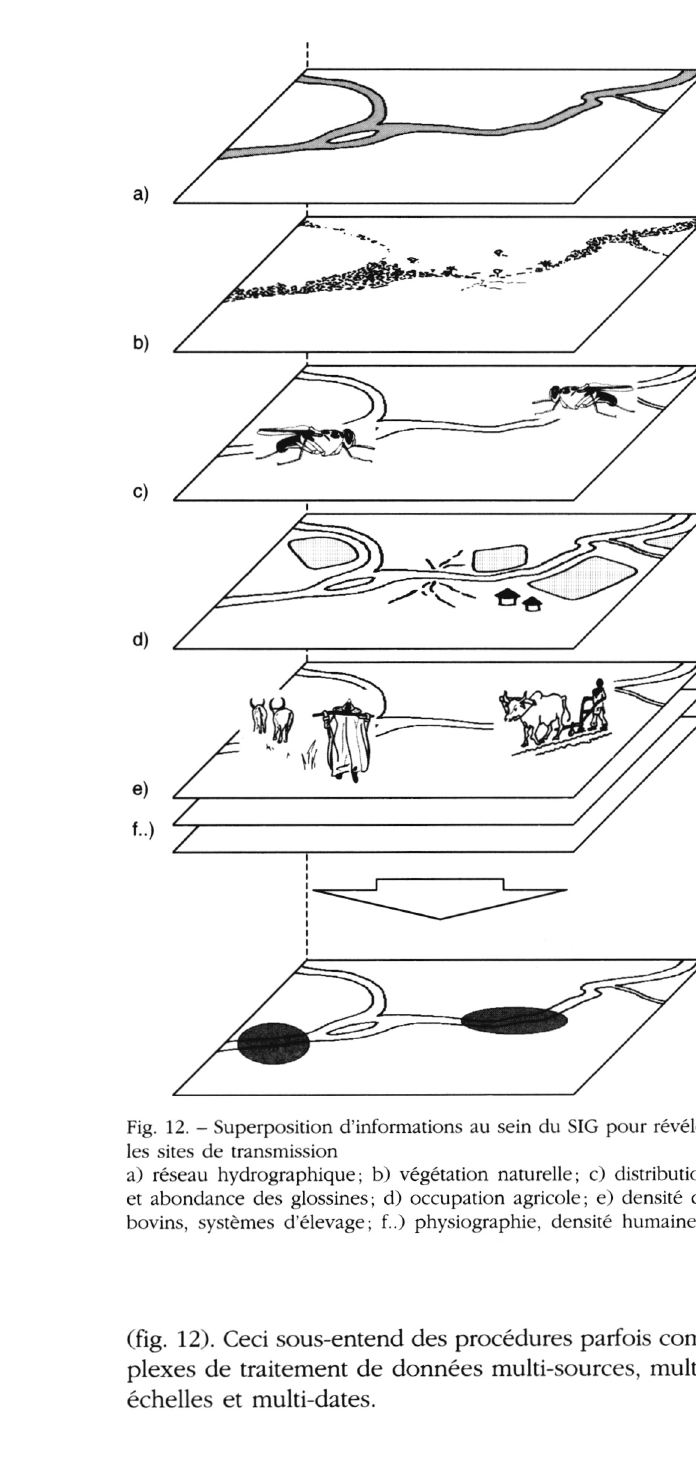
(fig. 12). Ceci sous-entend des procédures parfois com­ plexes de traitement de données multi-sources, multi- échelles et